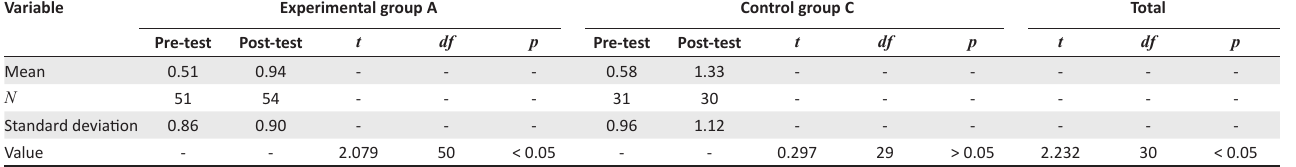
TABLE 4: Making predictions in English. Variable